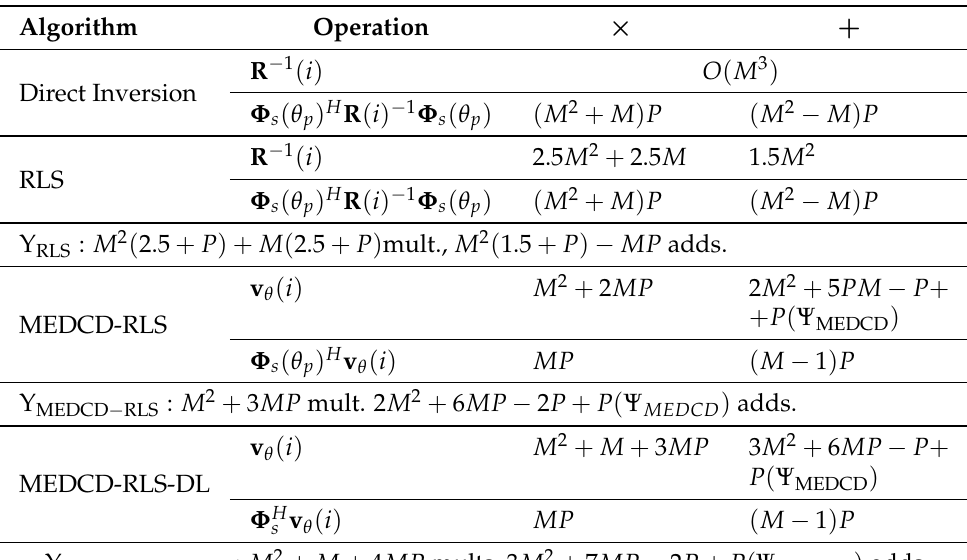
× M complex-valued 2 2